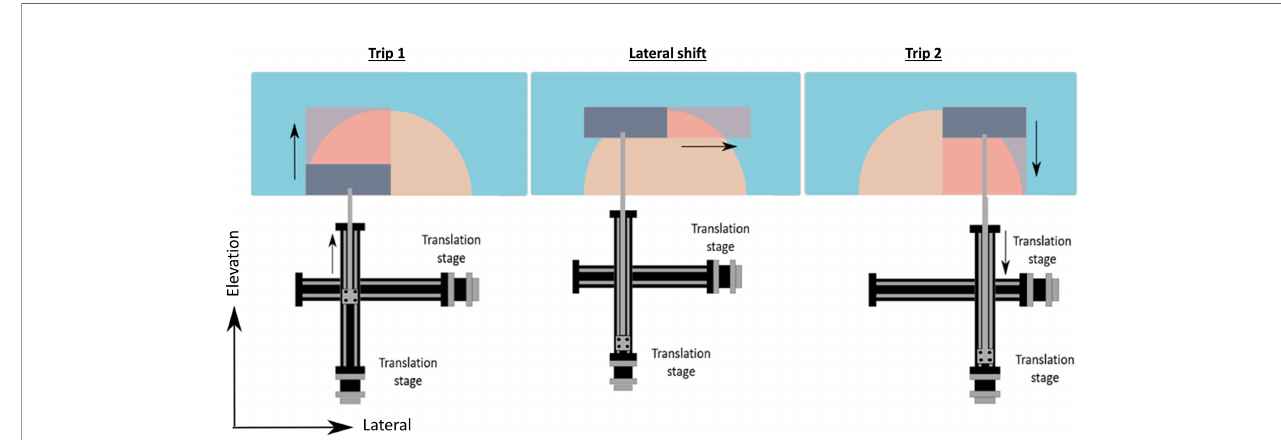
FIGURE 3 | Schematic drawing of the round-trip scanning. Trip 1: the transducer is placed alone the left side of the breast and scans away from the chest wall; Lateral shift: lateral movement of 85.6 mm; Trip 2: the transducer scans toward the chest wall to cover the right half of